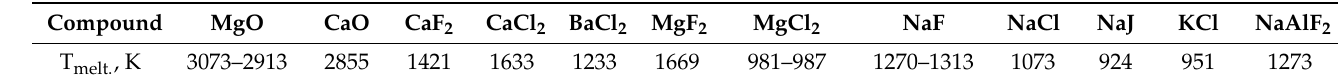
Table 3. Melting points of flux additives. Reprinted/adapted with permission from Ref [21]. 1964, Nikolsky, B.P.; Rabinovich, V.A.